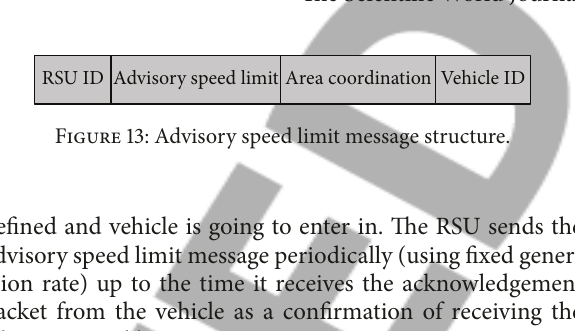
of single-hop transmission of broadcast messages [59, 60].